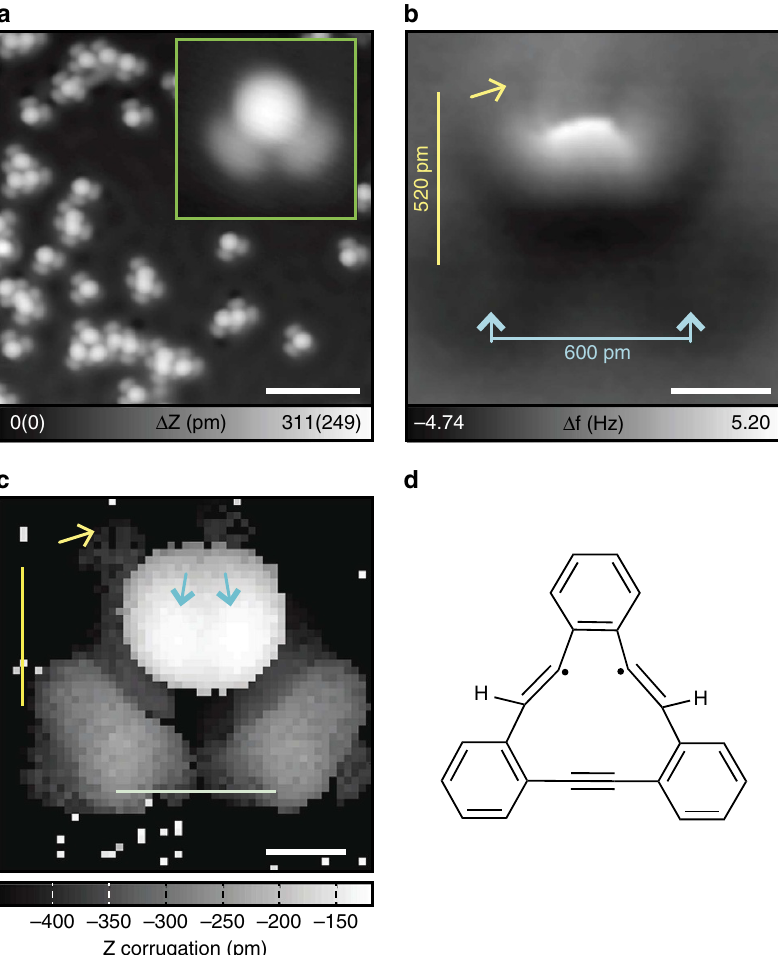
Figure 2 | First reaction on Cu(111). ( a ) Large-scale STM topography of tDBA as deposited on Cu(111) at 150K. Inset shows the close view of the single molecule. ( b ) Corresponding AFM image, measured at a constant height. ( c ) Corrugation image, extracted via the three-dimensional frequency shift landscape. ( d ) Proposed chemical structure of the first product. Measurement parameters: V tip ¼ (cid:2) 200mV and I ¼ 2pA in a and V tip ¼ (cid:2) 200mV and I ¼ 1pA in (inset). V tip ¼ 0mV and A ¼ 60pm in b , c . Scale bar, 4nm in a . White, blue and yellow scale bars, 300pm, 600pm and 520pm in b , c